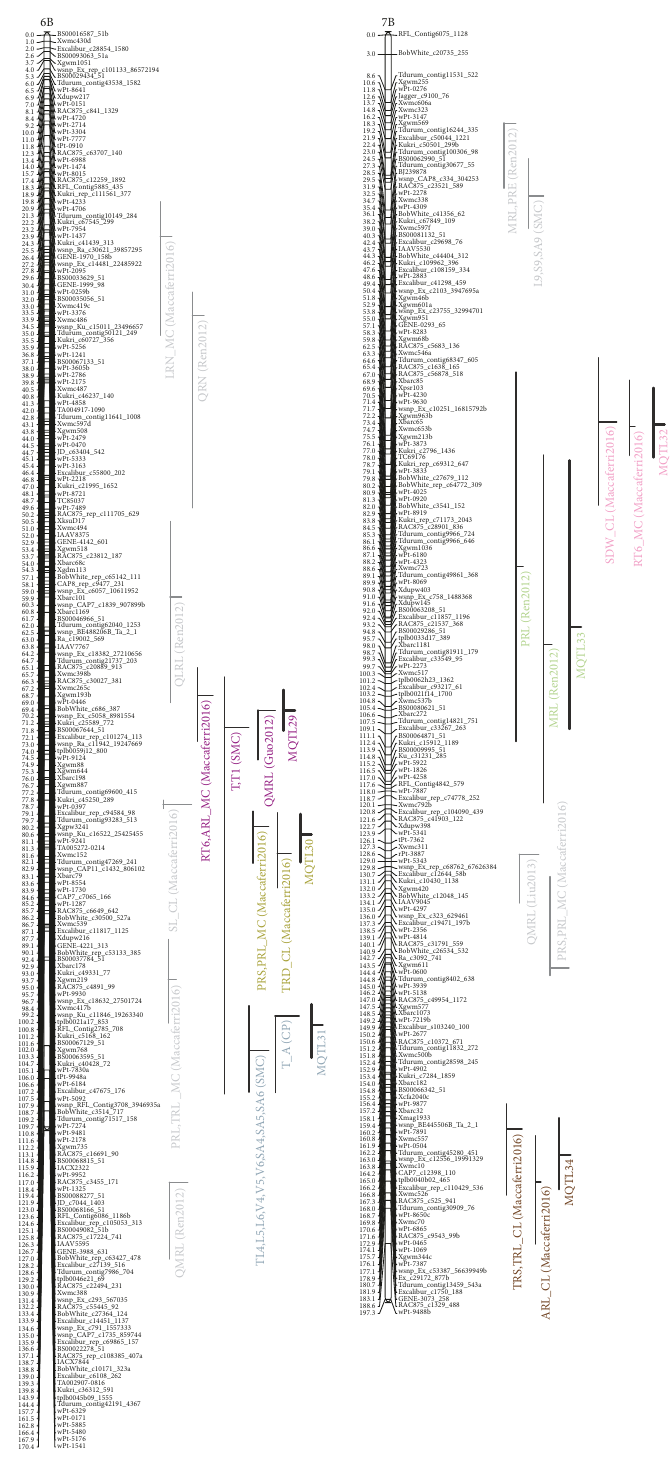
Figure 2: Integrated map in wheat for the QTL and the MQTL identi fi ed through the meta-analysis for the root morphological traits. QTL from literature are not indicated with the QTL name reported in the correspondent study but with a nomenclature in which the trait and the reference are reported, as indicated in Table S 1 , for clarity. The same for the QTL identi fi ed in the present study, which are reported with the acronym “ SMC ” (i.e., “ Simeto ” × “ Molise Colli ” population). The genetic position of the Rht-B1 locus on chromosome 4B is also reported. Vertical lines on the right of the chromosomes indicate the con fi dence intervals, and horizontal lines indicate the peak marker positions, where the length represents the percentage of variability explained by the QTL. The MQTL are in bold, while the single QTL are in gray. The names of the QTL grouped in the same MQTL are in the same